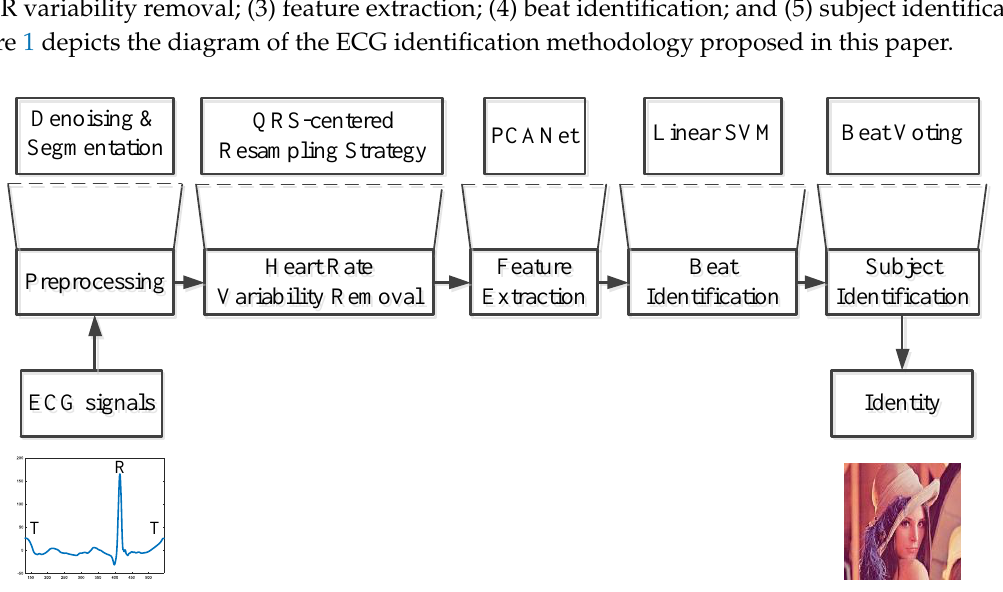
Figure 1. Diagram of electrocardiogram (ECG) identification methodology proposed.